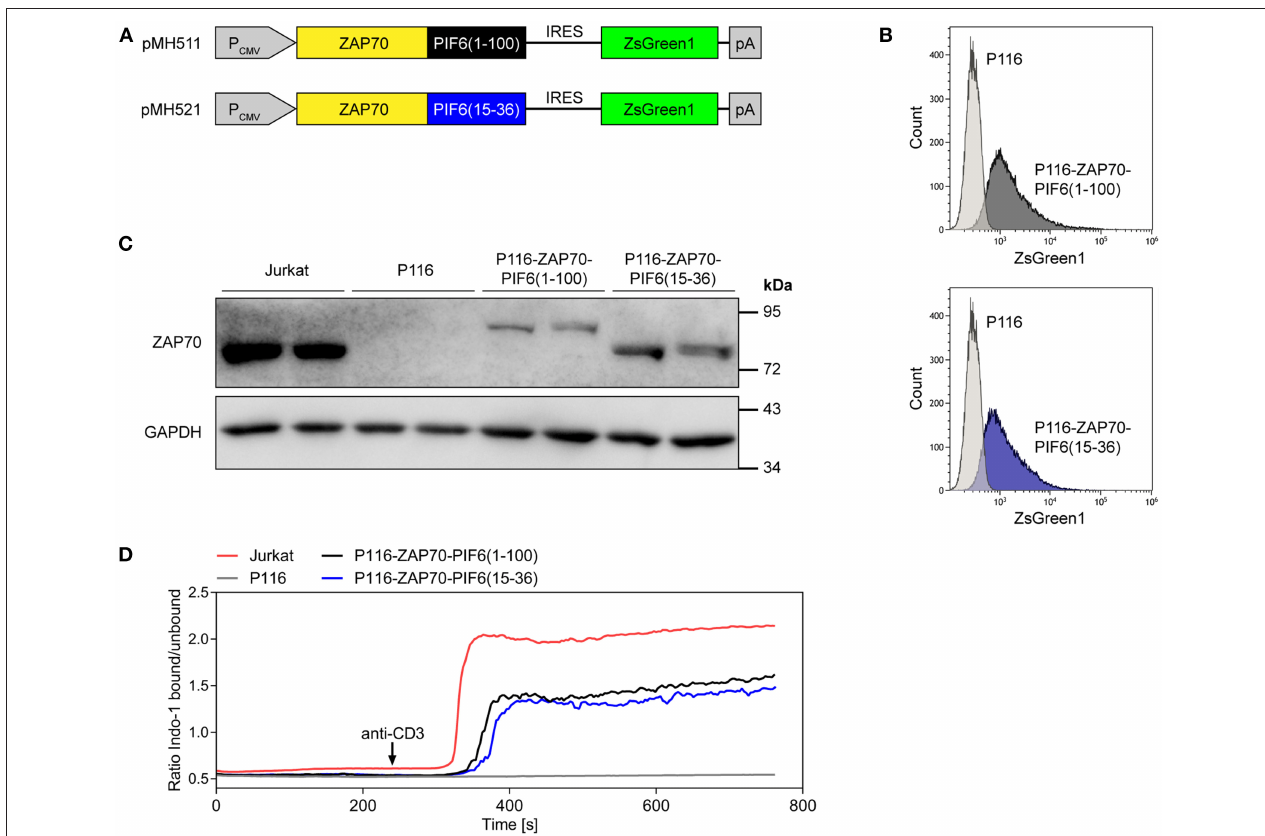
FIGURE 4 | Generation and characterization of P116-based cell lines stably expressing ZAP70-PIF6(1-100) or ZAP70-PIF6(15-36). (A) Lentiviral vectors encoding the depicted constructs for expression of ZAP70-PIF6(1-100) or ZAP70-PIF6(15-36) and the fluorescent protein ZsGreen1 under control of the constitutive CMV promoter (P CMV ). Transduced P116 cells were sorted based on ZsGreen1 fluorescence. (B) After culturing the two sorted cell lines generated in (A) , ZsGreen1 fluorescence of the cell lines in comparison to parental P116 cells was analyzed by flow cytometry. (C) Expression of ZAP70 in different cell lines. The cell lines indicated were analyzed for ZAP70 and GAPDH expression by SDS-PAGE and Western blotting. (D) Restoring anti-CD3 induced Ca 2 + -flux in P116 cells stably expressing ZAP70-PIF6(1-100) or ZAP70-PIF6(15-36). The Indo-1 fluorescence of Indo-1-stained cells was measured by flow cytometry, as a readout for the intracellular Ca 2 + concentration. After 240s of the recording the cells were stimulated with 1 µ g ml − 1 of an anti-CD3 antibody (indicated by the